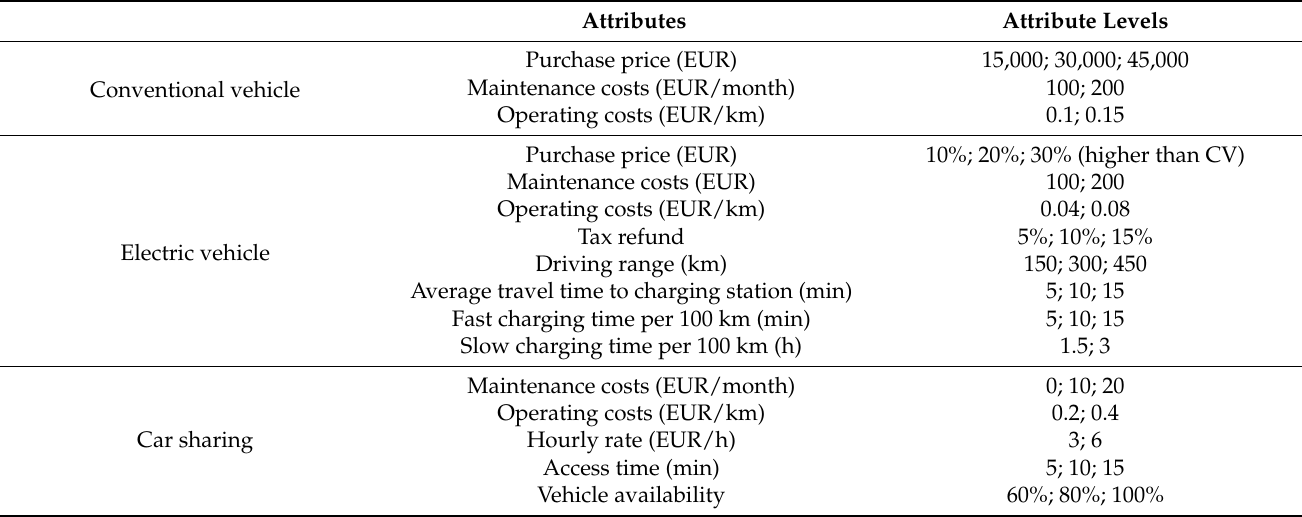
Table 1. Selected attributes and attribute levels of mobility tools. Attributes Attribute Levels Conventional